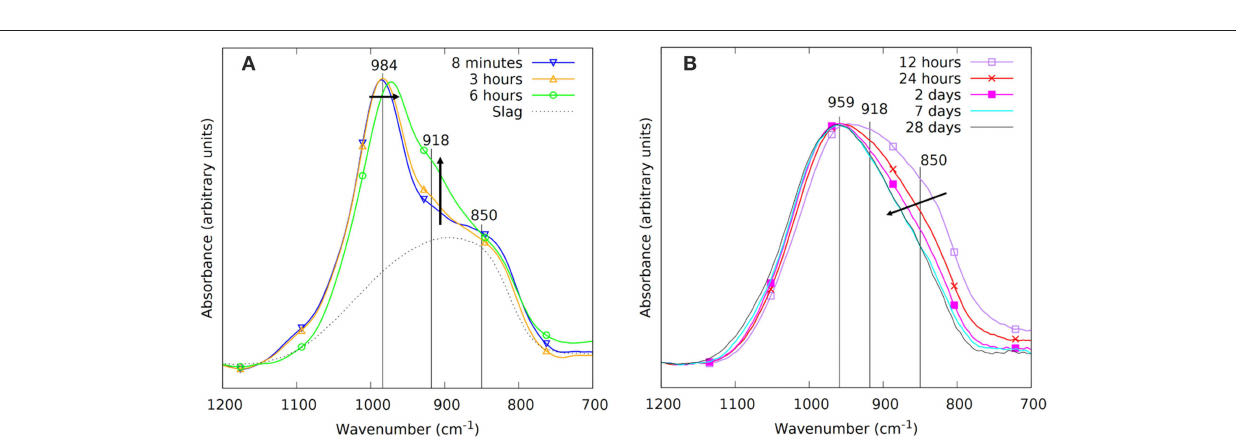
FIGURE 6 | The FTIR spectra during the first 28 days of reaction. The spectra before setting are shown on the left in (A) , these thus consider measurements in the liquid state, with the liquid in direct contact with the ATR crystal. The measurements on powdered samples after setting, pressed against the ATR crystal, are shown on the right in (B) .